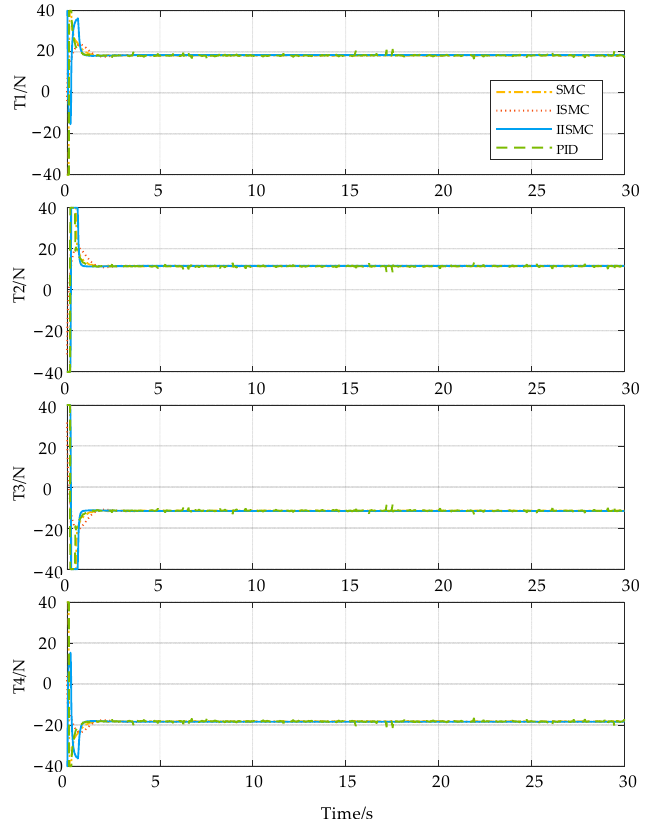
Figure 12. The thrust curve of the four heave thrusters in Scene 2.